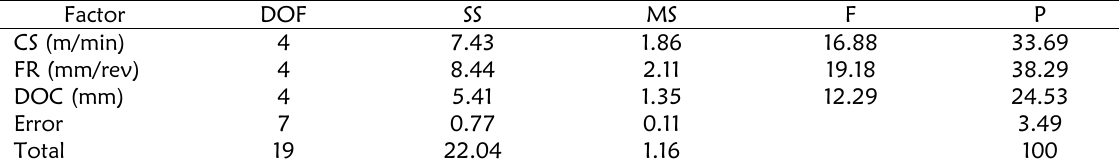
Table 13: ANOVA for surface roughness,